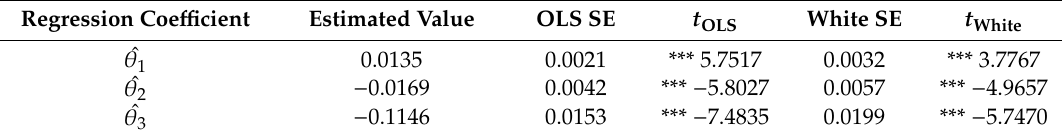
Table 4. Estimated results of regression coefficient for the cash holding ratio.